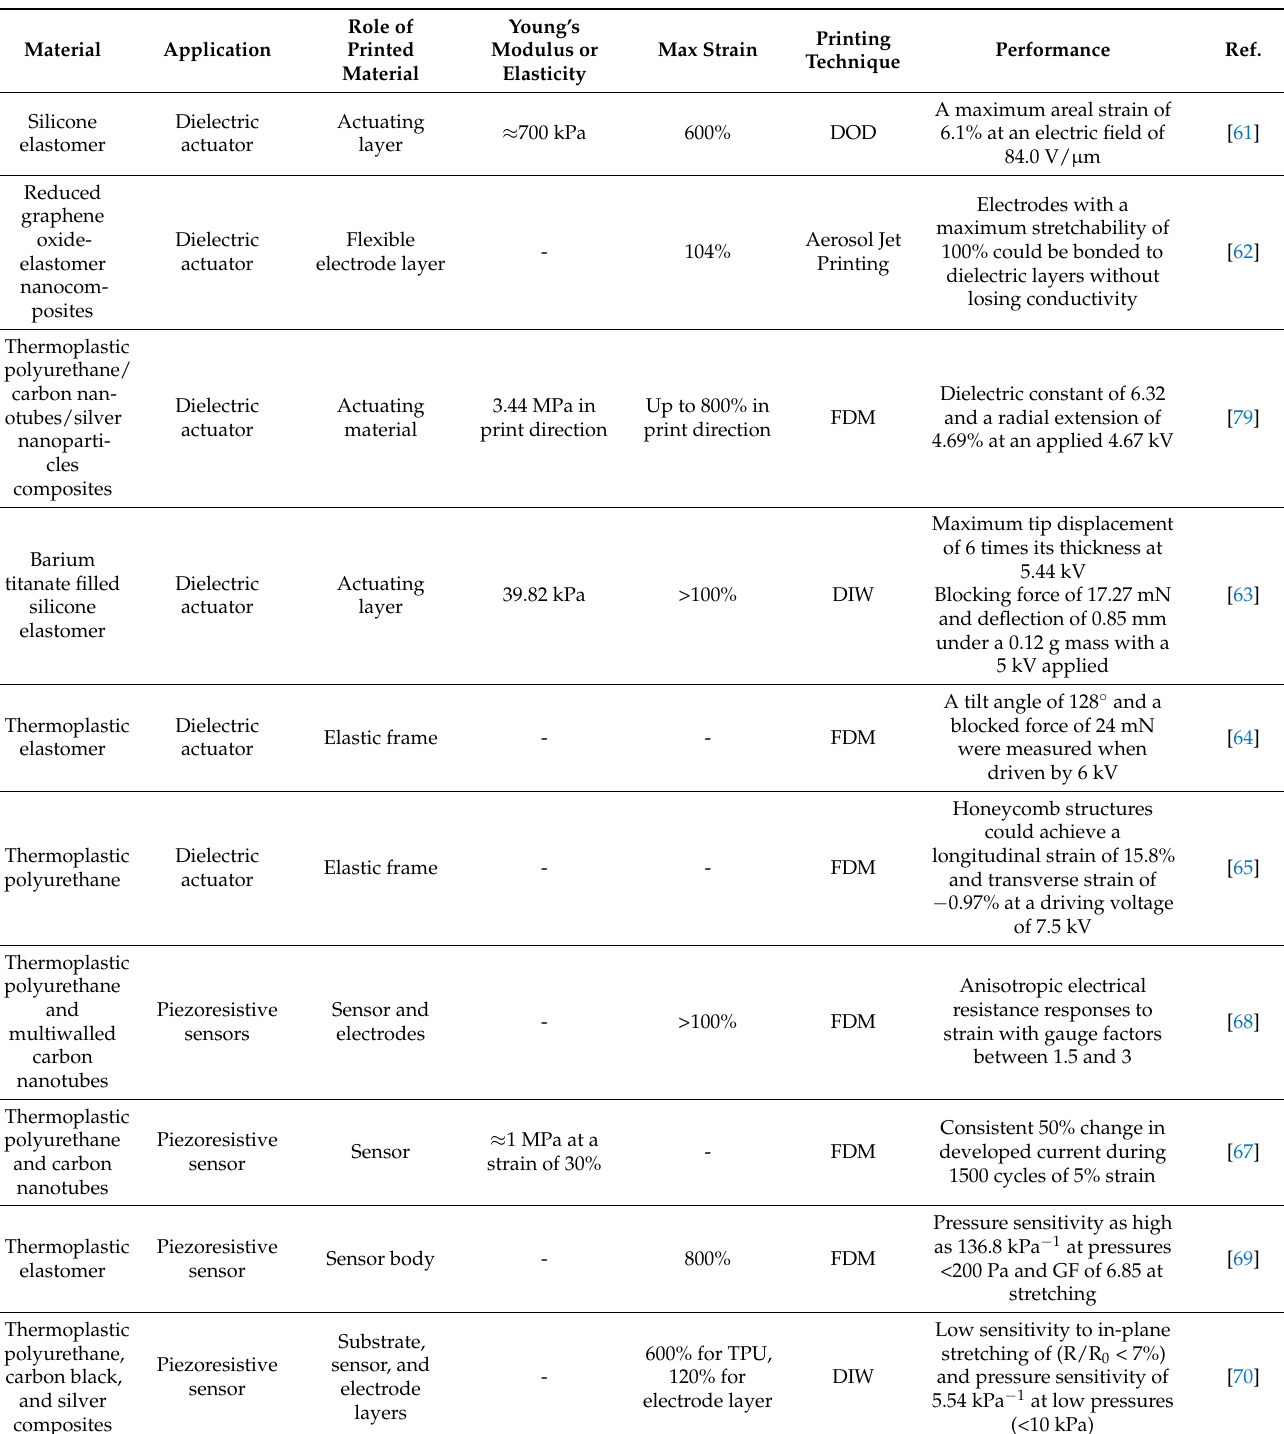
Table 4. Summary of various soft electronic polymers recently manufactured through AM for use as sensors and actuators and their performances